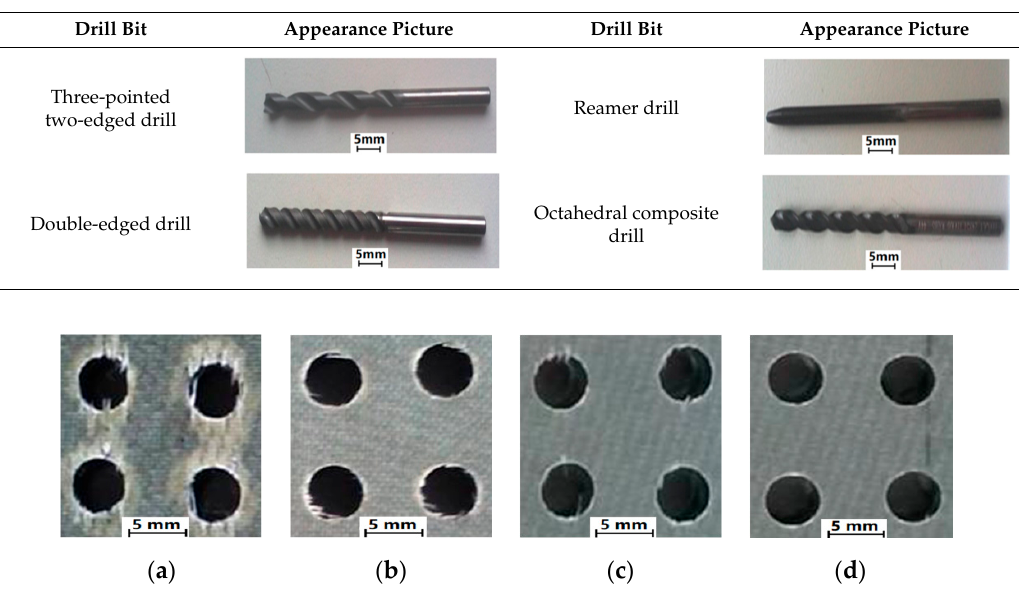
Table 1. Four types of drilling tool ( Φ 4.8 mm).